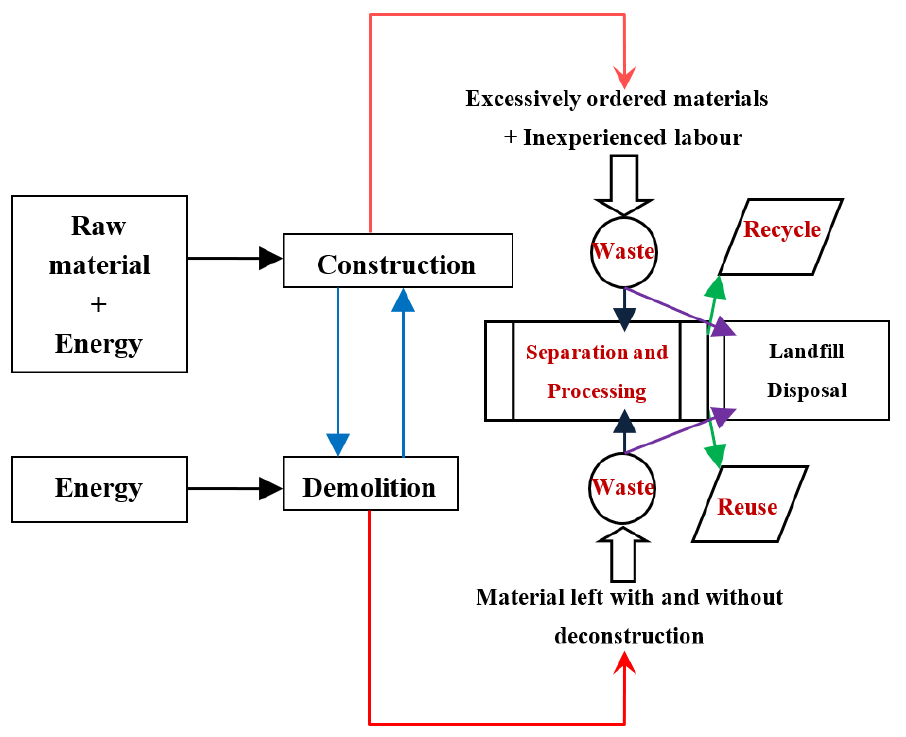
Figure 8. Schematic of demolition and construction materials from start to disposals/end-use [130,131].